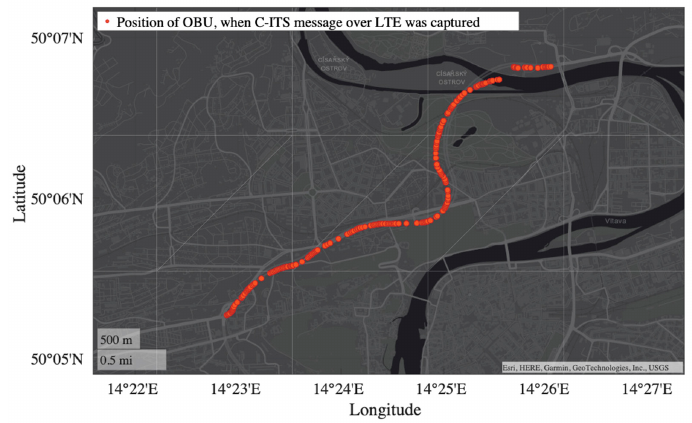
Figure 6. Captured C ‐ ITS messages from the backend over LTE.